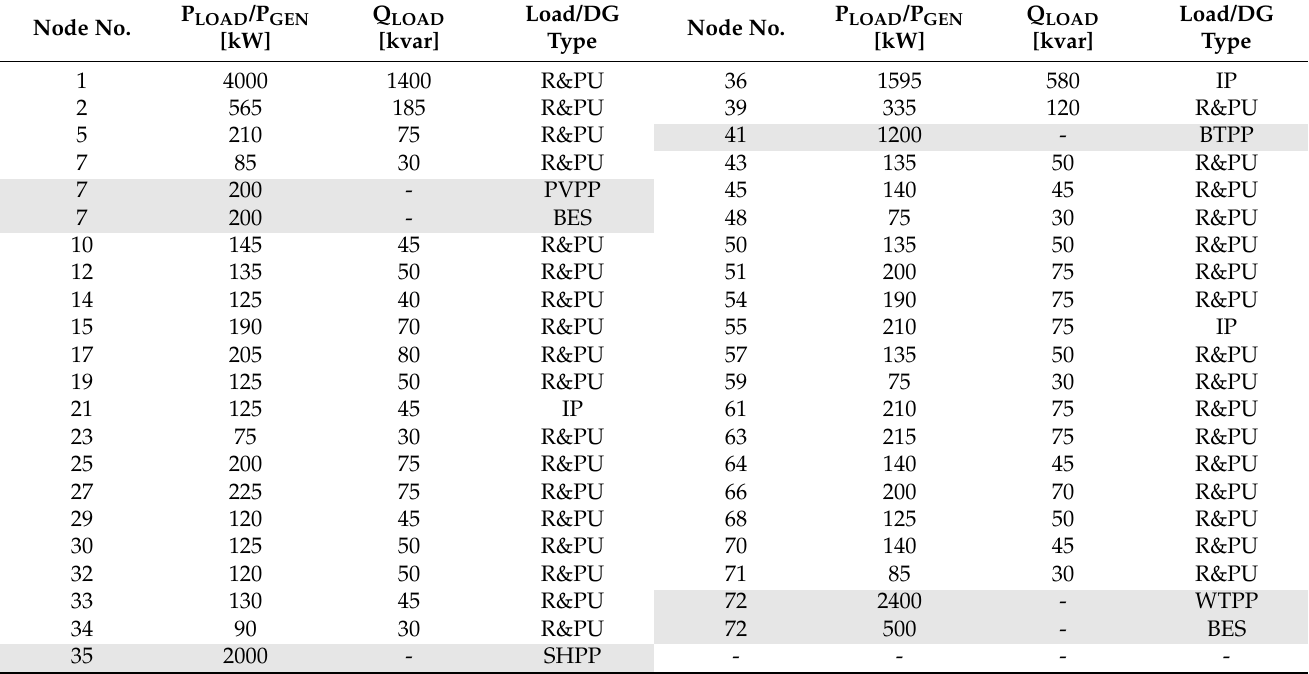
Table A3. Distributed generation sources and energy consumers connected to the rural MV distribu- tion network.